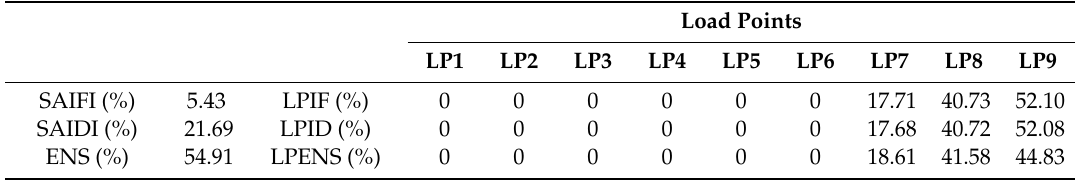
Table 4. Feeder and load point reliability indices improvement for